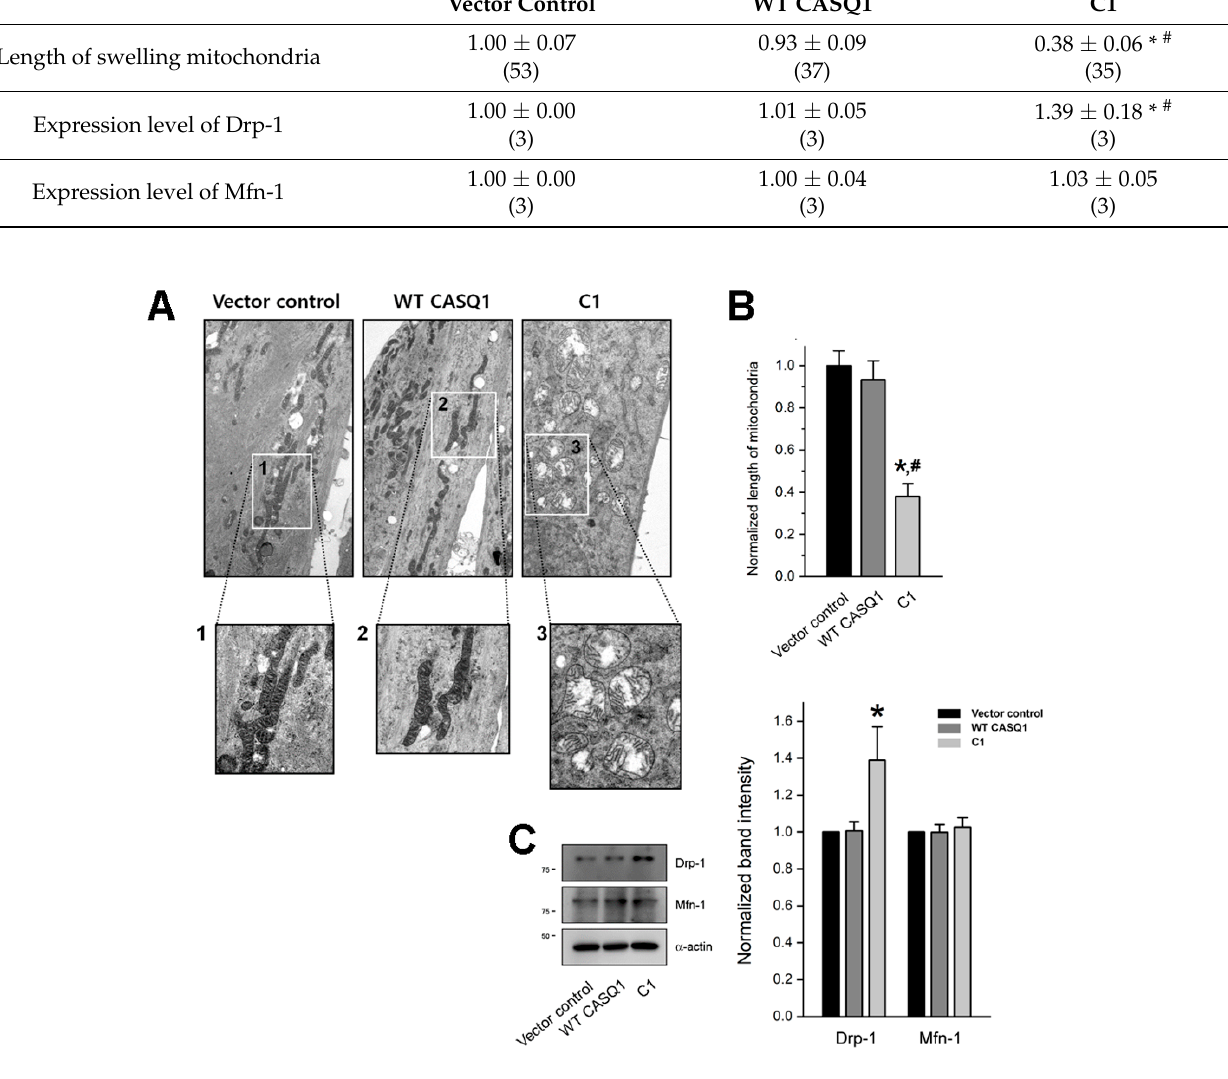
Figure 4. Abnormal mitochondria in the shape and the expression level of Drp-1 or Mfn-1: ( A ) Mitochondria in the myotubes were observed using TEM. Areas in the numbered boxes (from 1 to 3) were enlarged. Swelling mitochondria were found in C1-expressing myotubes. The bar represents 2 µ m. ( B ) The length of the swelling mitochondria was measured, and the results are summarized as histograms. The values were normalized to the mean values of the vector control. The values are presented as the mean ± SEM for the number of mitochondria in Table 2. ( C ) The myotube lysate was subjected to immunoblot assays with antibodies against Drp-1 or Mfn-1. α -actin was used as a loading control. Three independent experiments per protein were conducted. The expression level of each protein normalized to the mean value of the vector control is presented as histograms (Table 2). * Significant difference compared with vector control ( p < 0.05). # Significant difference compared with WT CASQ1 ( p < 0.05). Table 2. Length of mitochondria and expression level of Drp-1 or Mfn-1 in mouse primary skeletal myotubes that ex- pressed the WT CASQ1 or C1 region. The values are presented as the mean ± SEM for the number of mitochondria or experiments shown in parentheses. The values were normalized to the mean values of the vector control. * Significant difference compared with vector control ( p < 0.05). # Significant difference compared with WT CASQ1 ( p < 0.05).